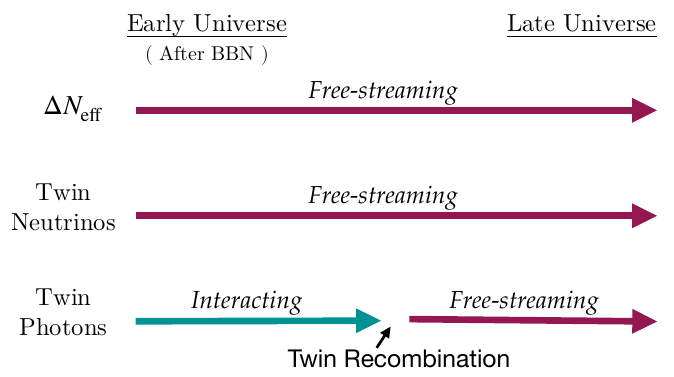
Figure 1. Pictorial representation of the phases of twin